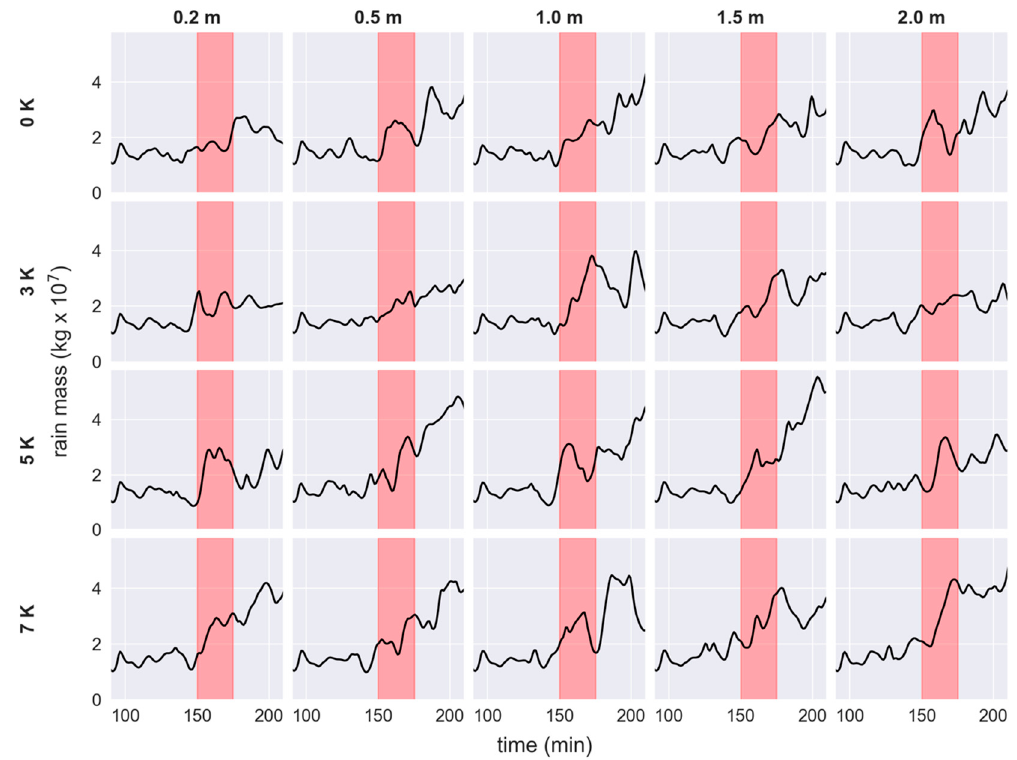
Figure 17. Same as Figure 16, except for rain mass.